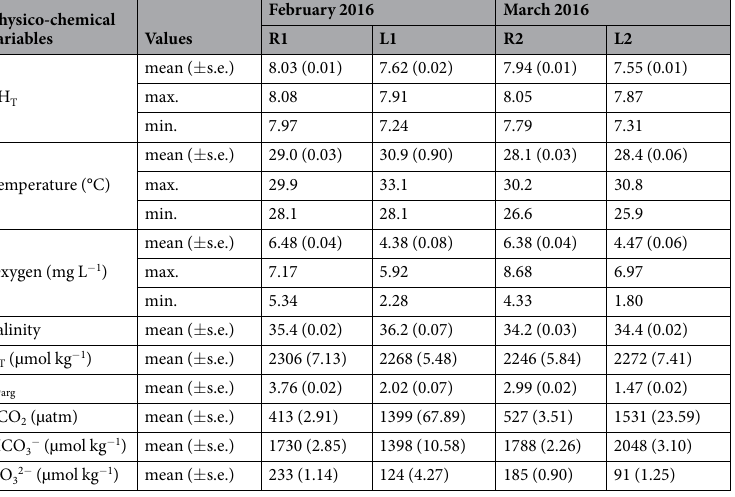
Table 1. Data from the semi-closed lagoon of Bouraké (L1, L2), and adjacent reference reef sites (R1, R2). Data was collected over three days in February 2016 at the lagoon site L1 and reference site R1, and during eight days in March 2016 at L2 and R2. Total alkalinity ( A T ) was determined from discrete water samples (see Methods, n = 9 and 6 for R1, R2, n = 6 and 3 for L1, L2). For the remaining variables, n = 138 for R1 and L1; n = 408 for R2 and